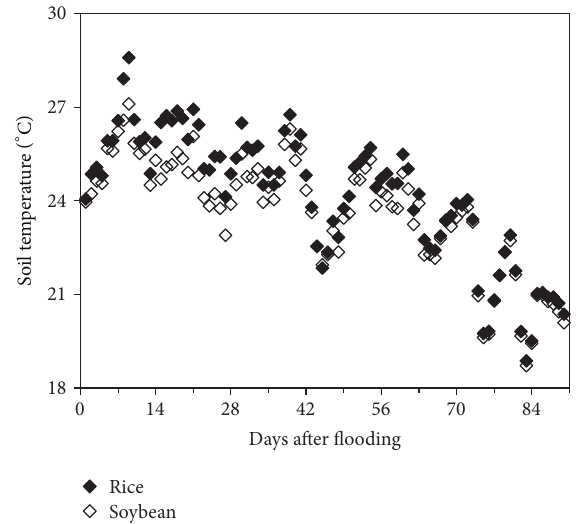
Figure 4: Daily mean soil temperature at the 7.5 cm depth over the flooded portion of the 2013 growing season for rice and soybean previous crop treatments at the Northeast Research and Extension Center in Keiser,